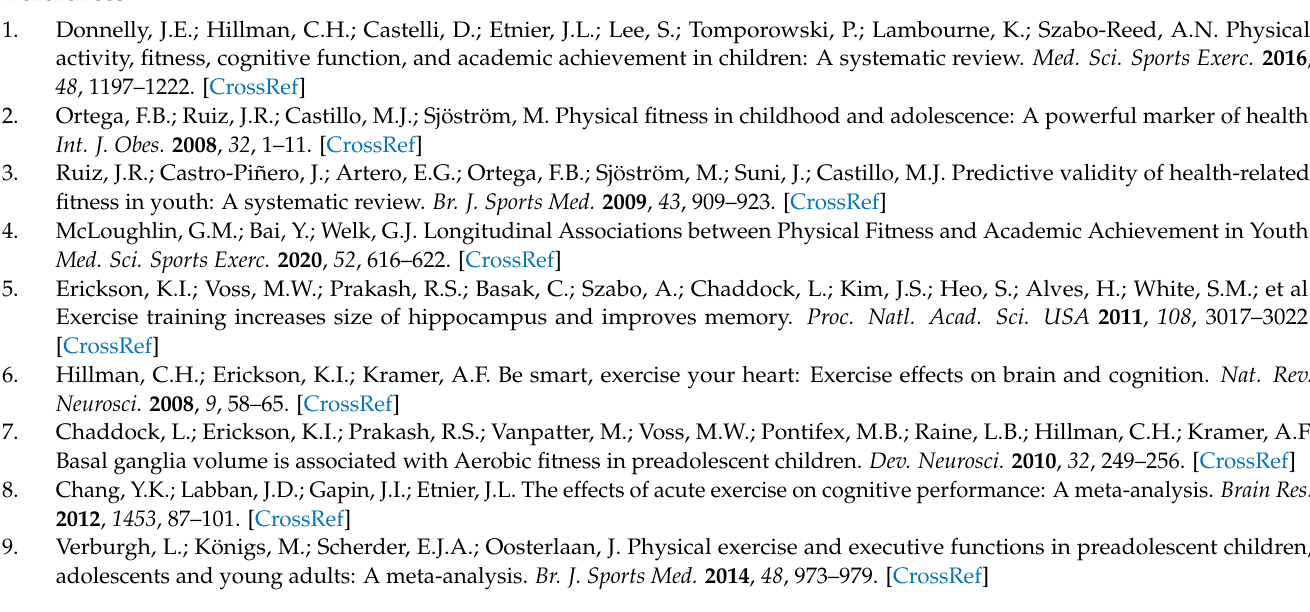
Table S1: Bivariate Correlations